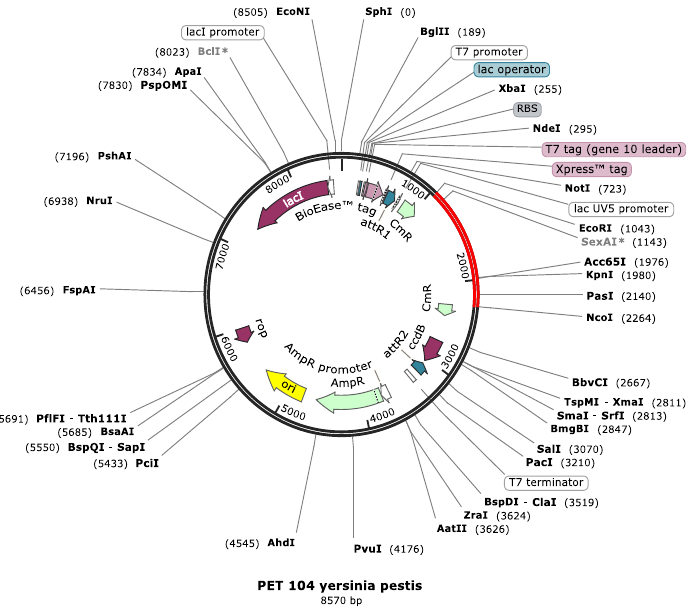
Figure 9. The pET-104 vector along with the vaccine construct inserted between the restriction sites with ECOR1 upstream and NCO1